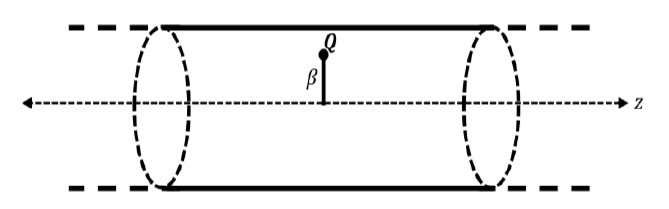
Figure 2. An interior point Q inside a nanotube offset from the central axis by distance β